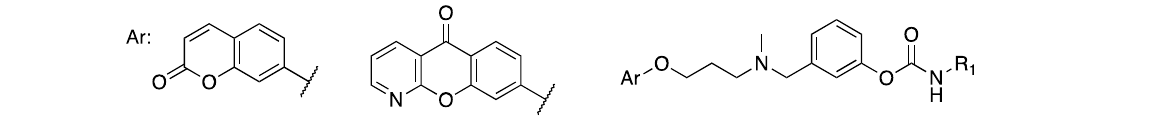
Table 8. Inhibitory activities of newly designed compounds against FAAH and human ChEs.